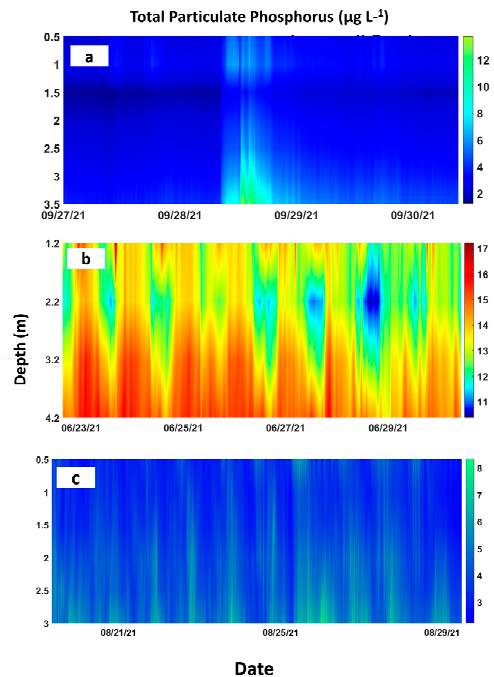
Figure 7. Vertical distribution of total particulate phosphorus estimates (TPP μ g L − 1 ) in the water column at the ( a ) upstream (UP), ( b ) downstream in June (DS − Jun), and ( c ) interior (INT) sites in the L − 29 Canal. The TPP from the lab-analyzed TSS (TPP in TSS) that was used to create the calibration curves (unit of mg g − 1 ) was multiplied by the TSS estimated from applying the calibration curves (units of mg L − 1 ) to obtain the TPP (unit of μ g L − 1 ) in the water column.